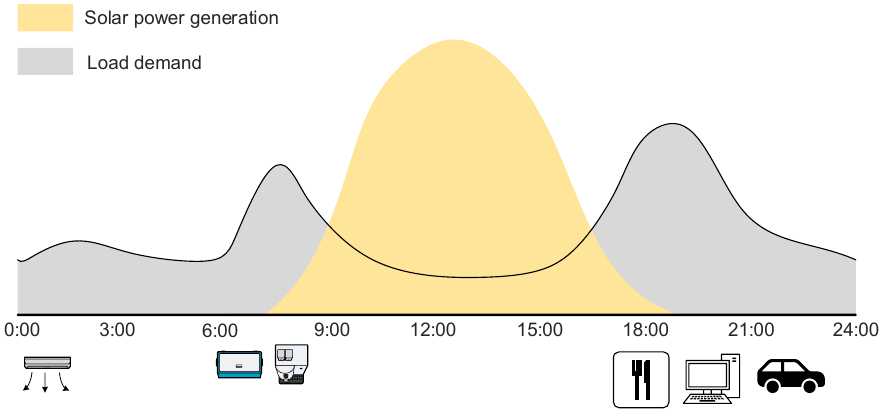
Figure 2. An illustration of mismatch between PV generation and load consumption.